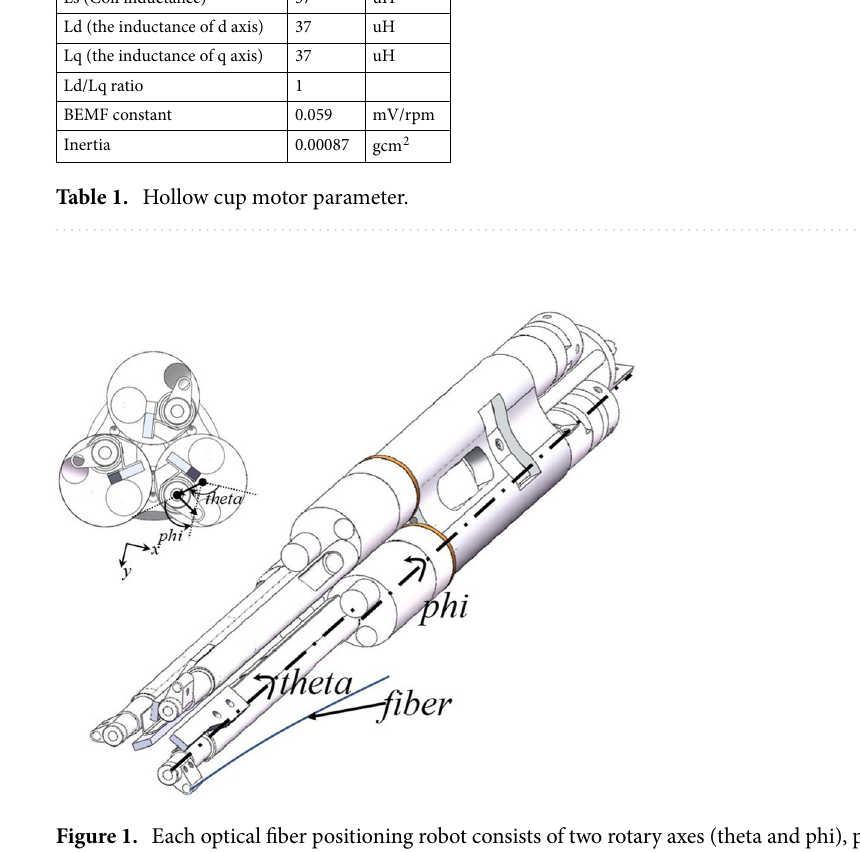
Figure 1. Each optical fiber positioning robot consists of two rotary axes (theta and phi), positioning the optical fiber on the focal panel in micrometer precison, and three such robots make a group.